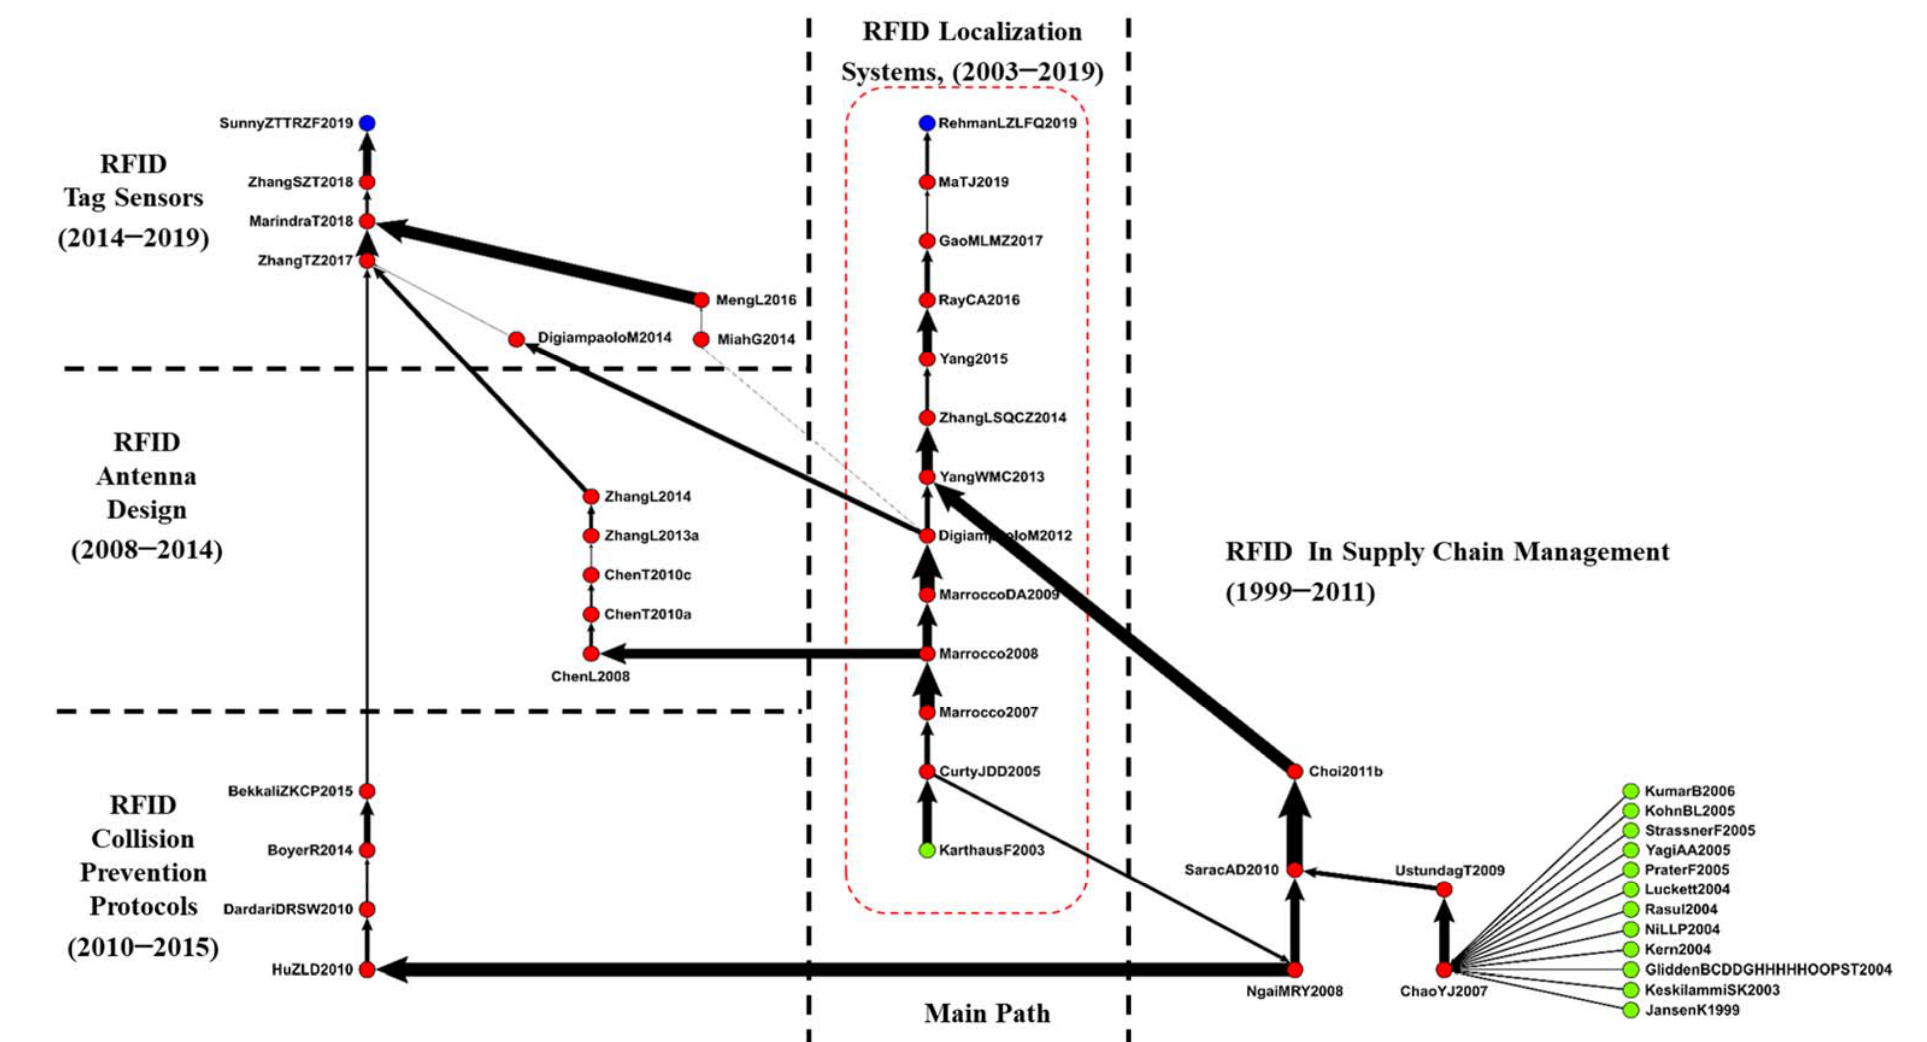
Figure 5. The development trajectory of academic papers on RFID research.